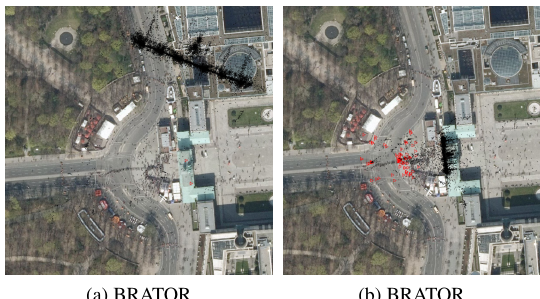
Figure 6. Result for BRATOR using the minimum number of 2 GNSS tags for georeferencing the model (a) . Using all available GNSS tags (b) the model is georeferenced correctly.